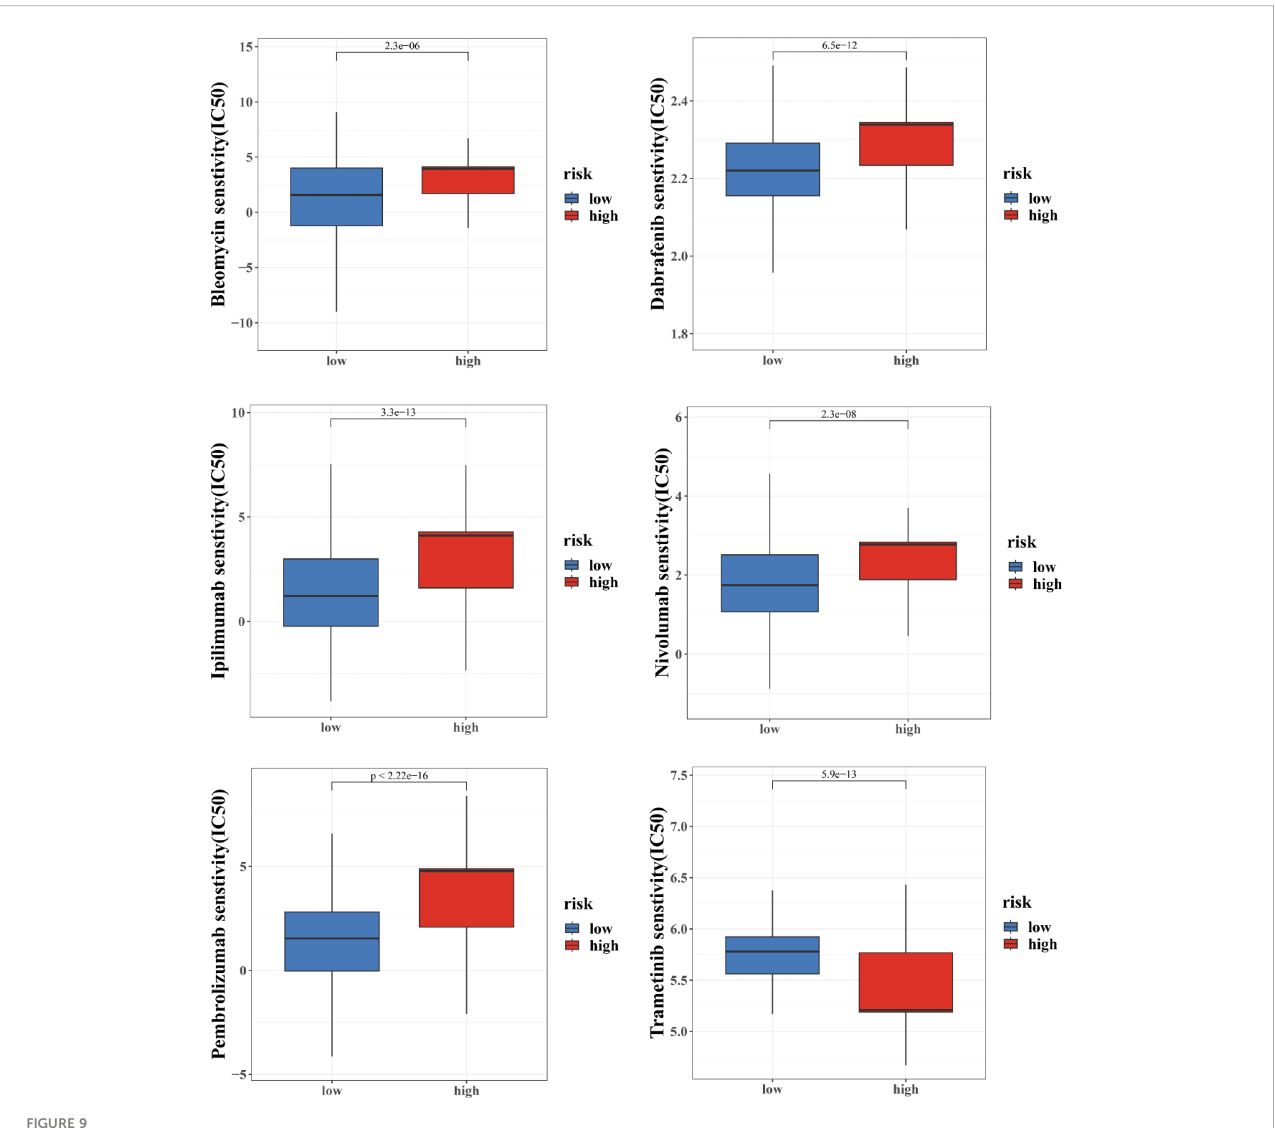
FIGURE 9 Medication sensitivity analysis based on the risk